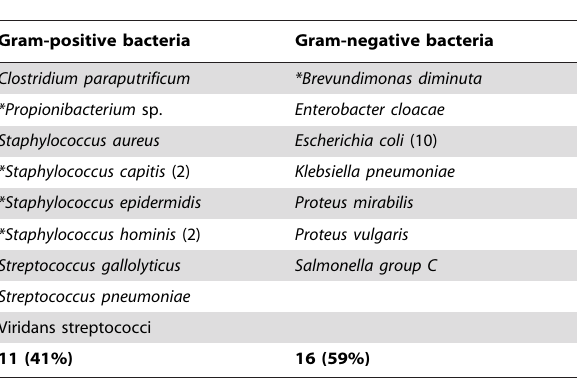
Table 1. Microorganisms grown from positive blood